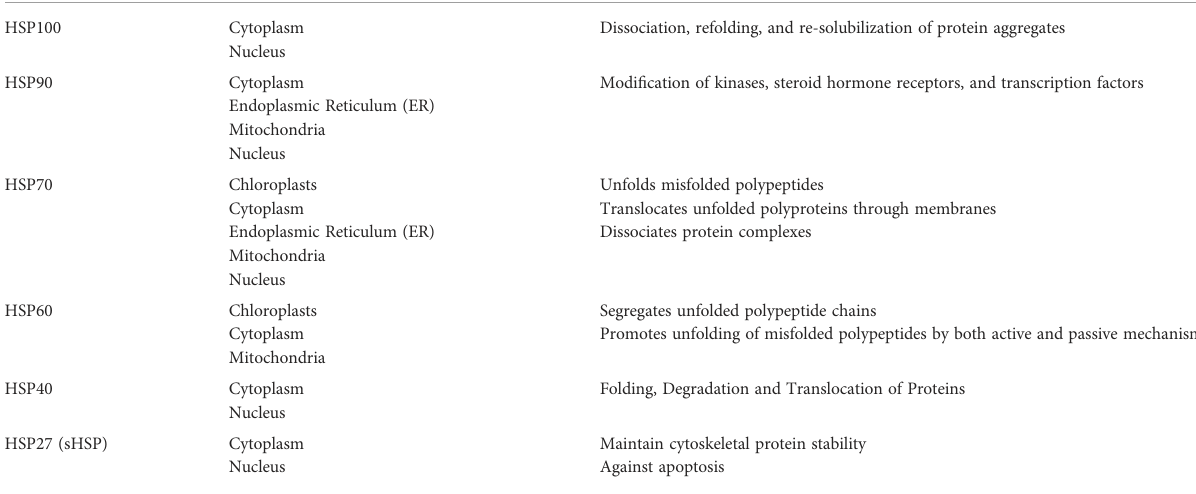
TABLE 1 Functions and distribution of heat shock